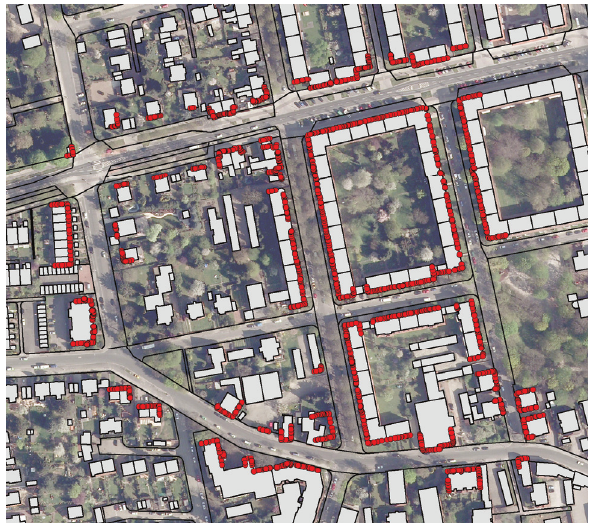
Figure 2. Test area in Hannover, Germany, with an area of 300 m x 300 m. Orthophoto overlaid with building footprints (gray area), road boundaries (black lines) and measured facade points (red dots).